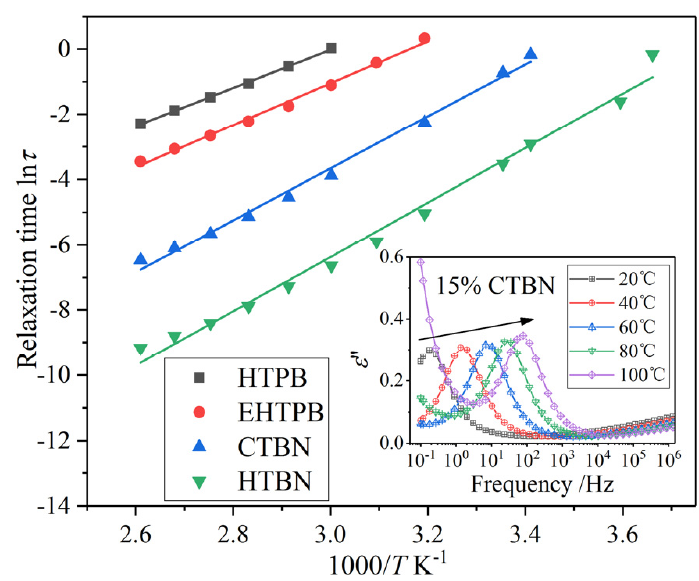
Figure 8. Relaxation time of interfacial polarization induced by different liquid rubber varies with temperature. The inset picture is the frequency spectrum of different temperature of sample with 15% CTBN, which shows the variation of the interfacial polarization. Table 1. Apparent activation energy of the interfacial polarization.